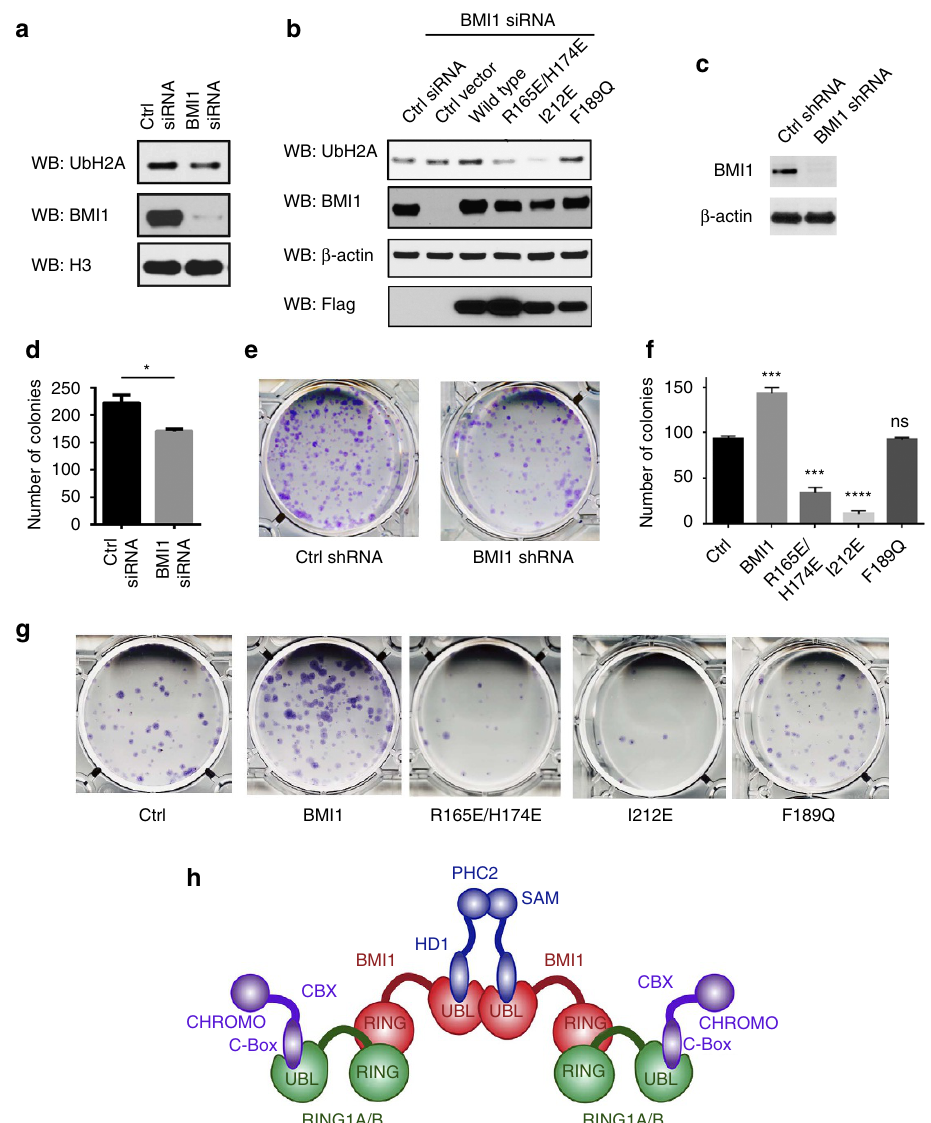
Figure 4 | Functional consequences of disrupting BMI1 protein–protein interactions and homo-oligomerization. ( a ) Analysis of the effect of BMI1 knockdown on Ub-H2A levels in HeLa cells. HeLa cells were transfected with control or BMI1 3 0 UTR siRNA and followed by immunoblot analysis 48h post transfection. ( b ) Characterization of Ub-H2A levels on overexpression of BMI1 mutants in HeLa cells. HeLa cells transfected with control or BMI1 3 0 UTR siRNA for 48h were transfected with plasmids encoding Flag-tagged full length wild-type BMI1 or three mutants and analysed using immunoblotting after 48h. ( c ) Inducible knockdown of BMI1 in U2OS cells using shRNA. U2OS cells carrying control or BMI1 shRNA were treated with doxycycline for 96h and cell lysates were analysed for BMI1 expression levels. ( d ) Quantification of colony numbers from the clonogenic survival assay in panel e demonstrating the effect of BMI1 knockdown on clonogenic potential of U2OS cells. U2OS cells were plated in triplicates and incubated for 14 days. Error bars represent s.d.